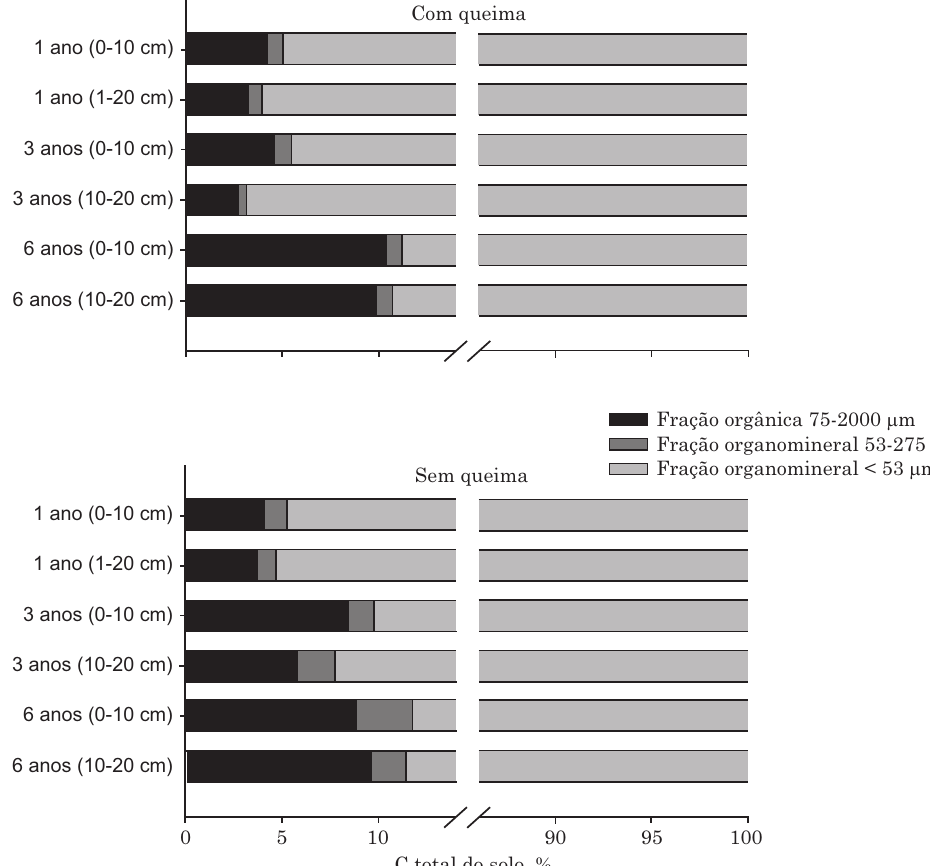
Figura 3. Participação relativa de diferentes frações do solo no teor total de C no solo em cronossequências de cana-de-açúcar colhida com e sem queima da palha